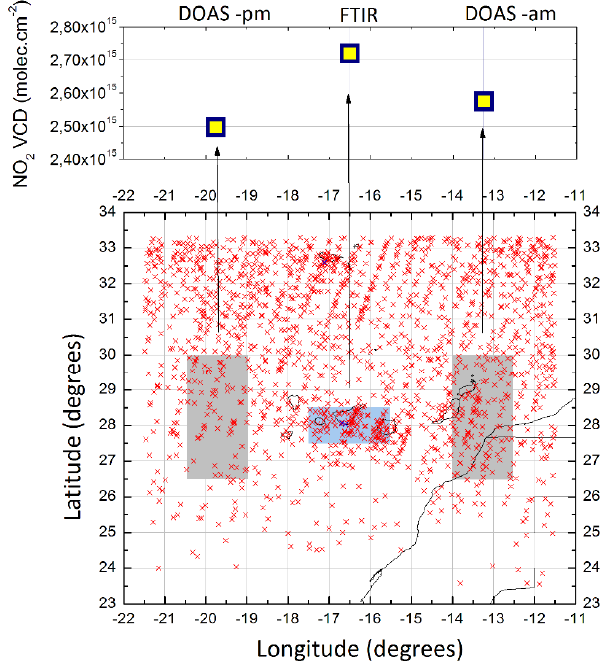
Figure 6. Areas where DOAS (grey rectangles) and FTIR (blue rectangle) are scanning the stratosphere. A complete year of SCIA- MACHY NO 2 vertical column density (VCD) with values above 3.3 × 10 15 moleccm − 2 is shown (red crosses). The value is arbi- trarily selected to provide a hint of the pollution influence over the area. Table 3. Statistics of the relative difference of the stratospheric NO 2 from ground-based and satellite instruments in percent. No. Mean Standard